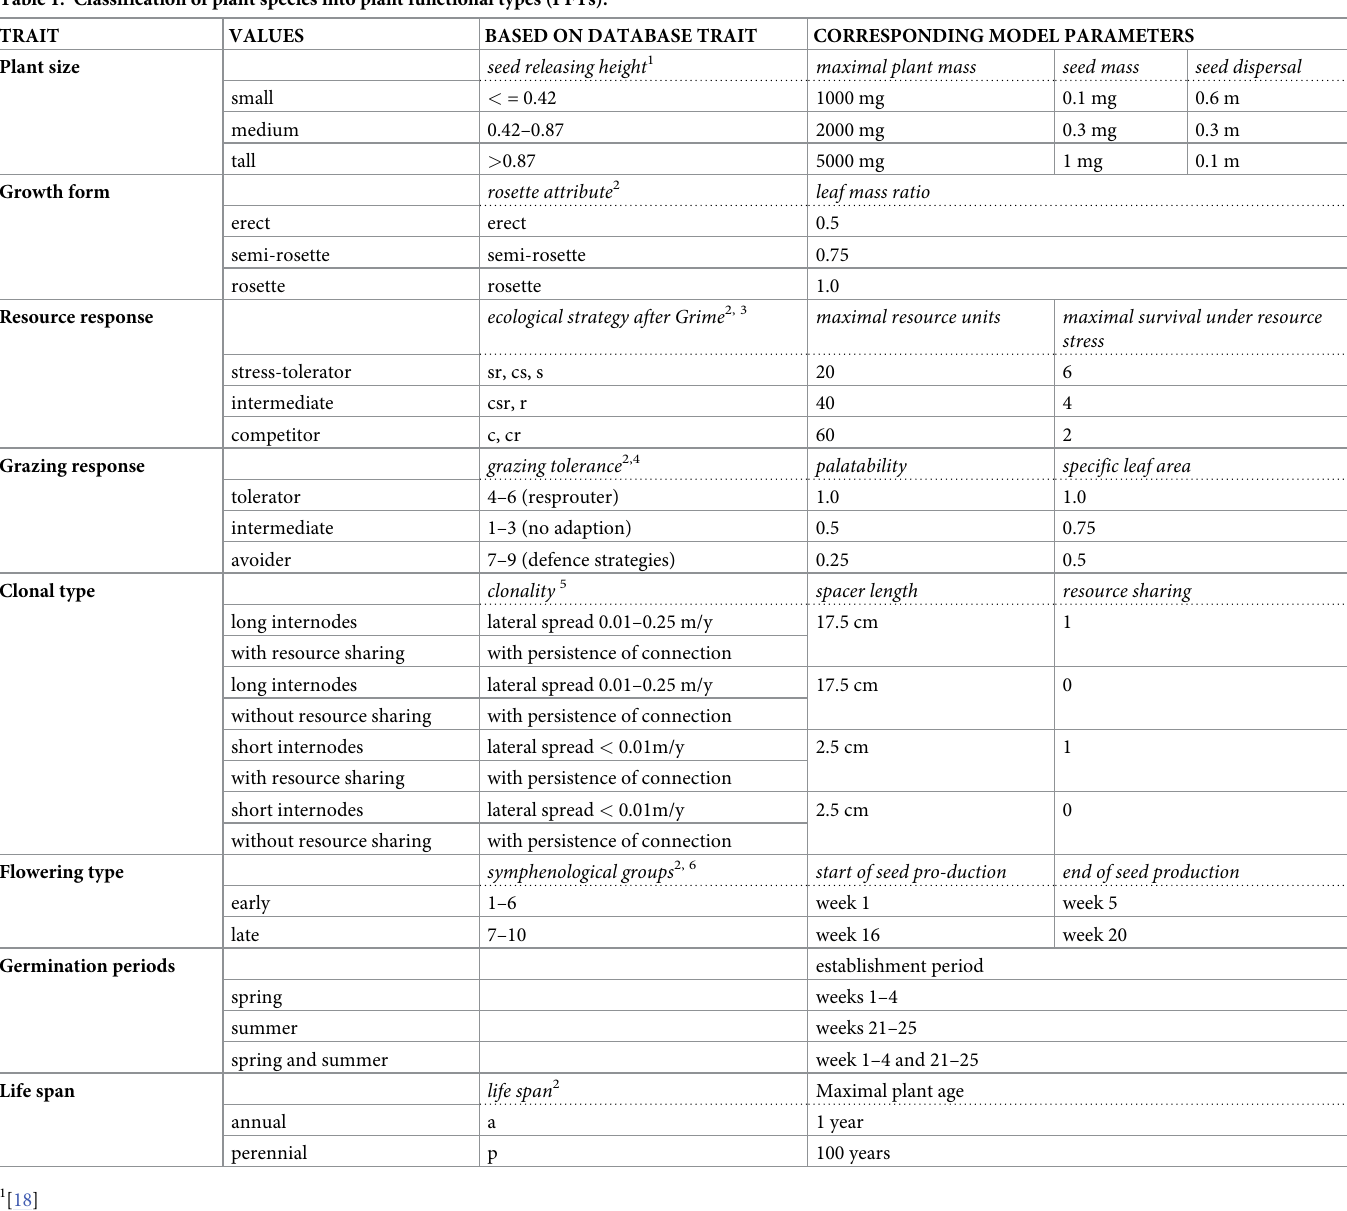
Table 1. Classification of plant species into plant functional types